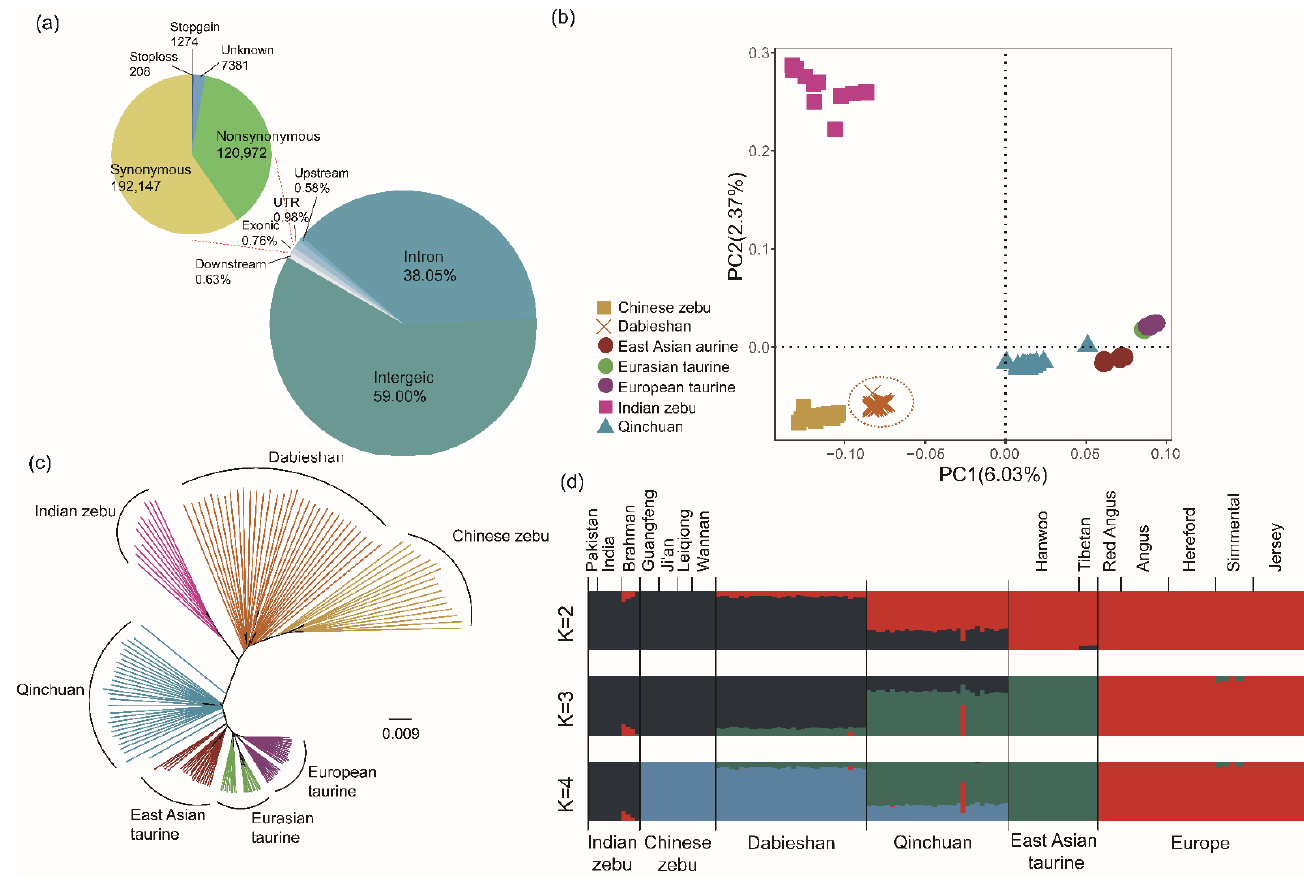
Figure 1. Population genetic structure and relationship among Dabieshan cattle using autosomal variants. ( a ) An NJ tree was constructed on the basis of 148 animals. ( b ) PCA showing PC 1 against PC 2. ( c ) Distribution of ANNOVAR annotation SNPs with whole-genome data. ( d ) Population ge- netic structure of cattle breeds using ADMIXTURE with K = 4.